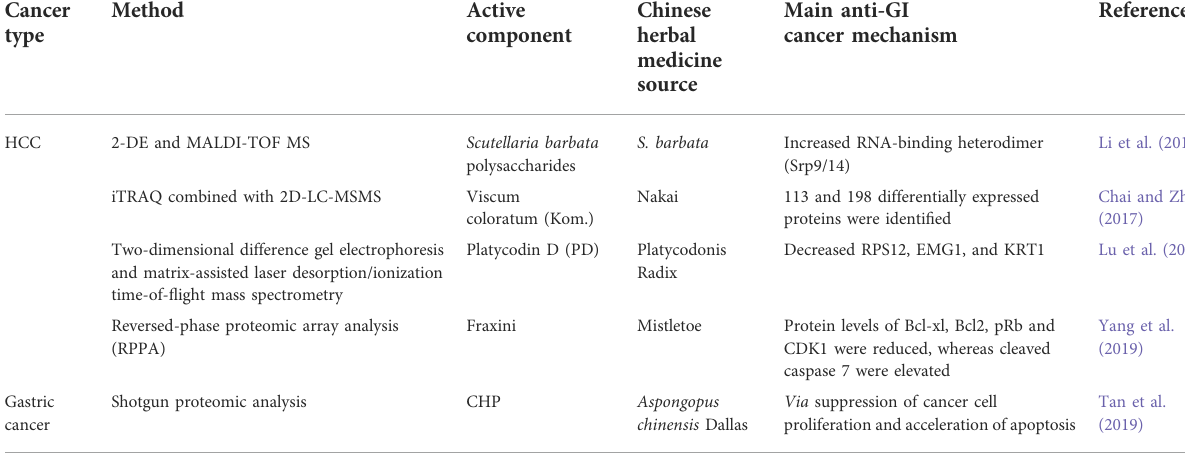
TABLE 2 Applications of proteomics approaches to study the mechanisms of Chinese herbal medicines in GI cancers.